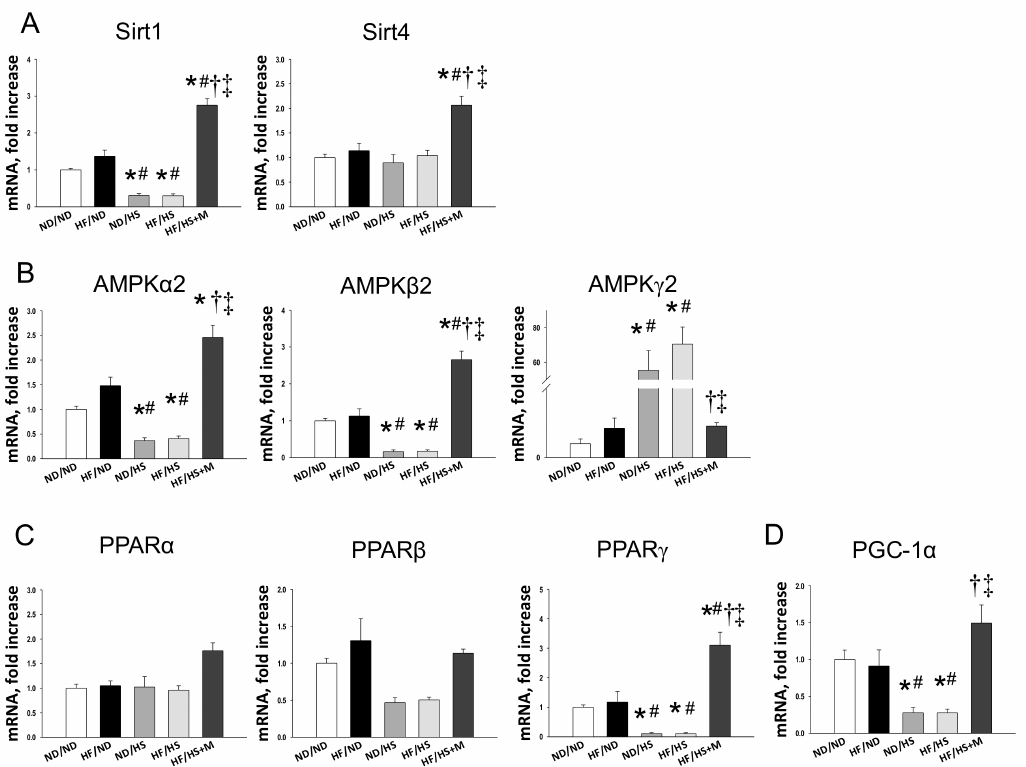
Figure 2. Effect of maternal and post-weaning high fructose (HF) intake, post-weaning high salt (HS) intake, and melatonin (M) on mRNA expression of ( A ) silent information regulator transcript 1 (SIRT1) and 4 (SIRT4); ( B ) AMP-activated protein kinase (AMPK) α -, β - and γ -subunits; and ( C ) Peroxisome proliferator-activated receptor (PPAR) α -, β - and γ -isoforms, and ( D ) PPAR γ coactivator-1 α (PGC-1 α ) in male offspring kidneys at 12 weeks of age. * p < 0.05 vs. ND/ND, # p < 0.05 vs. HF/ND, † p < 0.05 vs. ND/HS, ‡ p < 0.05 vs.